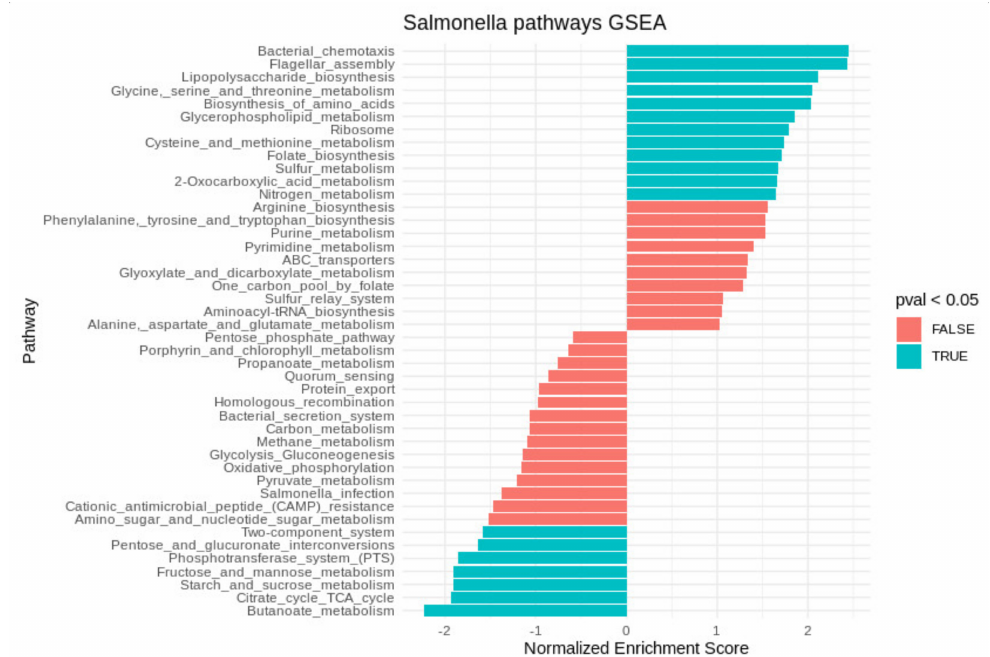
Figure 1. Gene set enrichment analysis performed using the fgsea package. Positive (normalized) enrichment scores indicate upregulation of genes in the pathway in Salmonella within Acanthamoeba . Negative (normalized) enrichment scores indicate downregulation of genes in the pathway in Salmonella within Acanthamoeba . Operon pathway annotation was determined against the KEGG